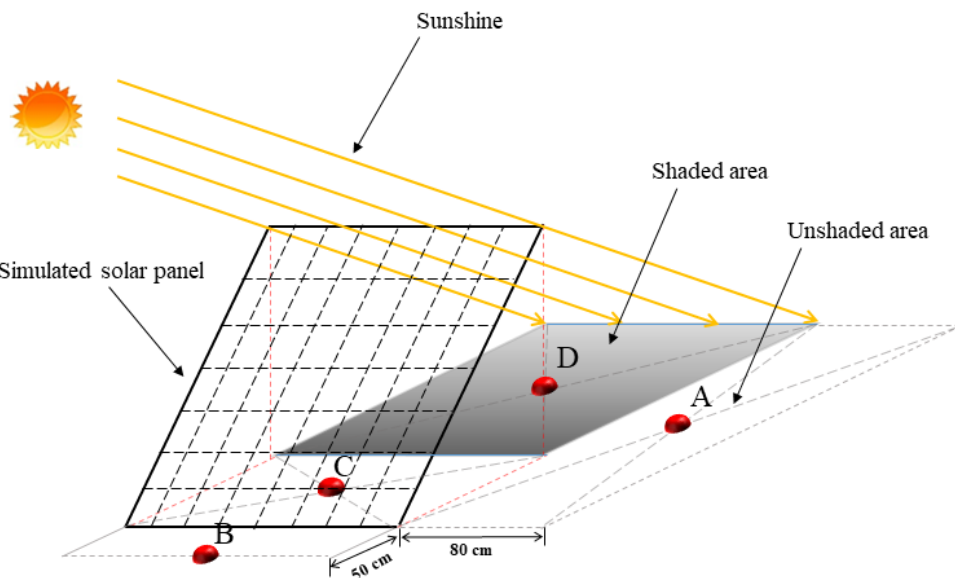
Figure 2. Schematic diagram of the arrangement of measurement points for the influence of photovoltaic simulation devices on the light intensity.